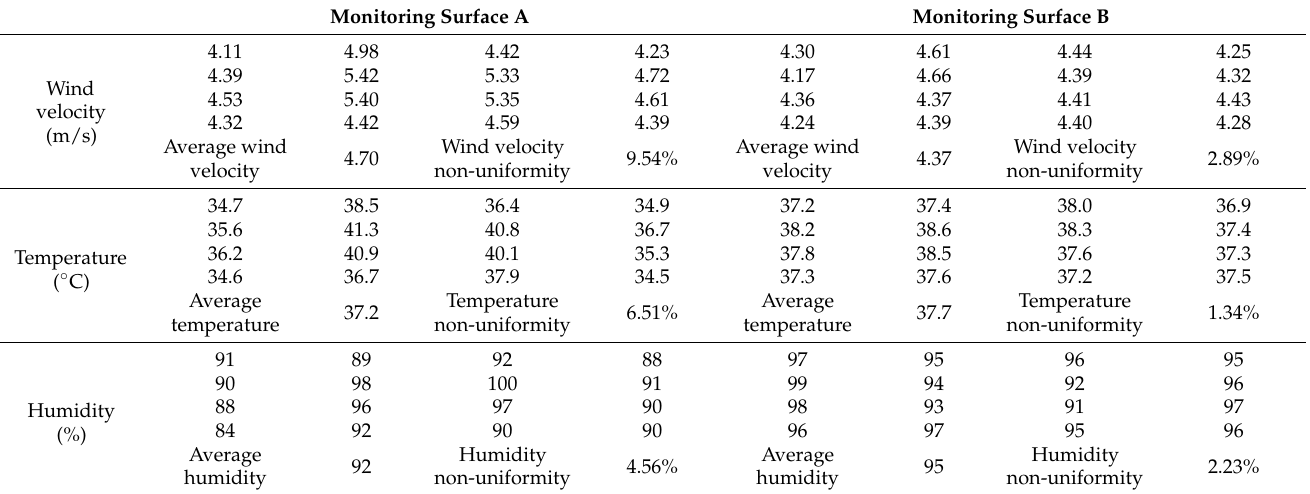
Table 3. Experimental data of wind velocity, temperature, and humidity of monitoring surface A and B. Monitoring Surface